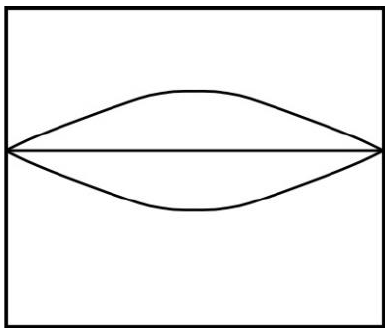
Figure 2. A sketch of a wave trapped in a box, like a sound wave in a musical instrument. Higher-pitched waves are possible, but not lower.